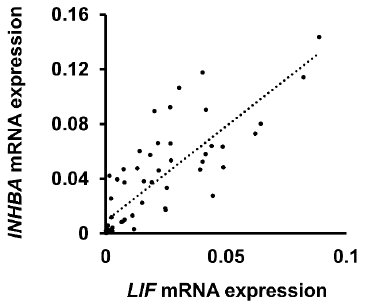
Figure 5. INHBA was moderately correlated with LIF in patients with OSCC. Correlation between LIF and INHBA in patients with OSCC ( R 2 = 0.67). The mRNA levels of patients’ samples were measured using real-time PCR. Data are presented as mean ± SD for mRNA expression.